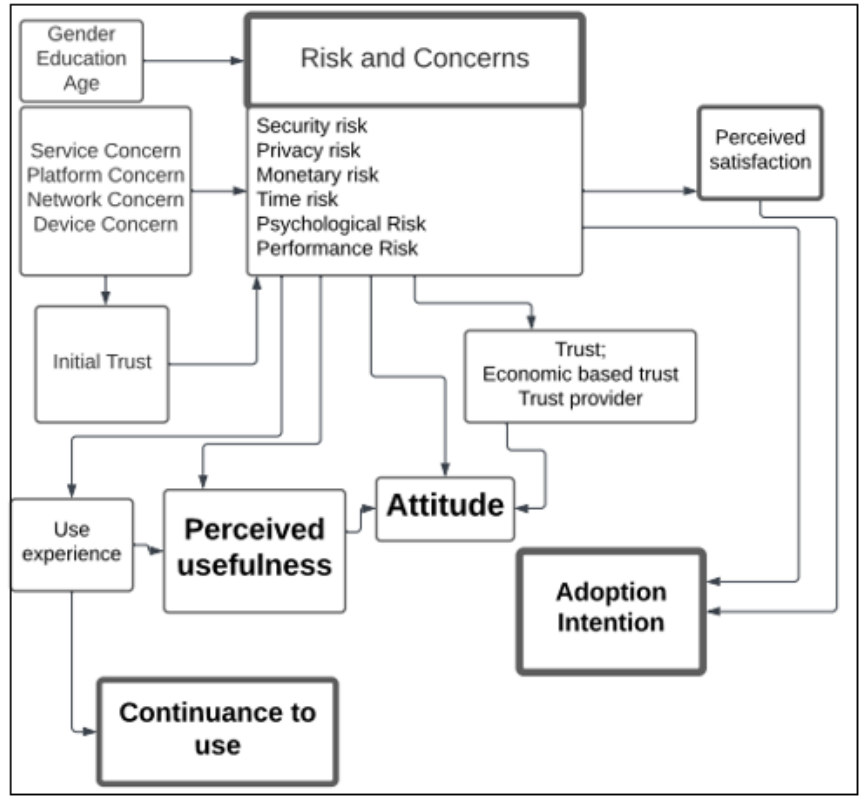
Figure 6. The determinants and consequences of risk.